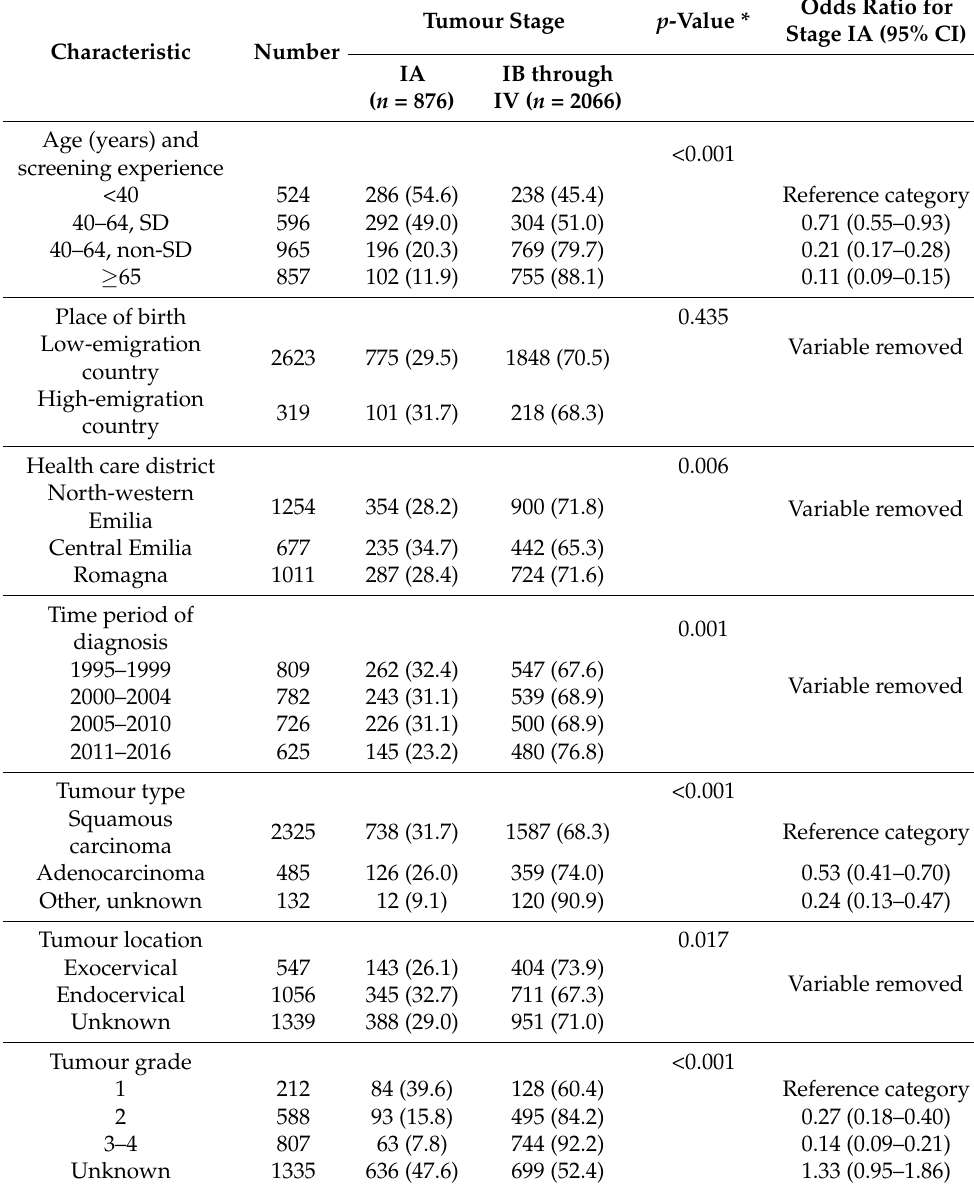
Table 2. Univariate and multivariate association of registered patient and disease characteristics with the likelihood of stage IA versus stage IB through IV cervical carcinoma. Emilia-Romagna Region, Italy